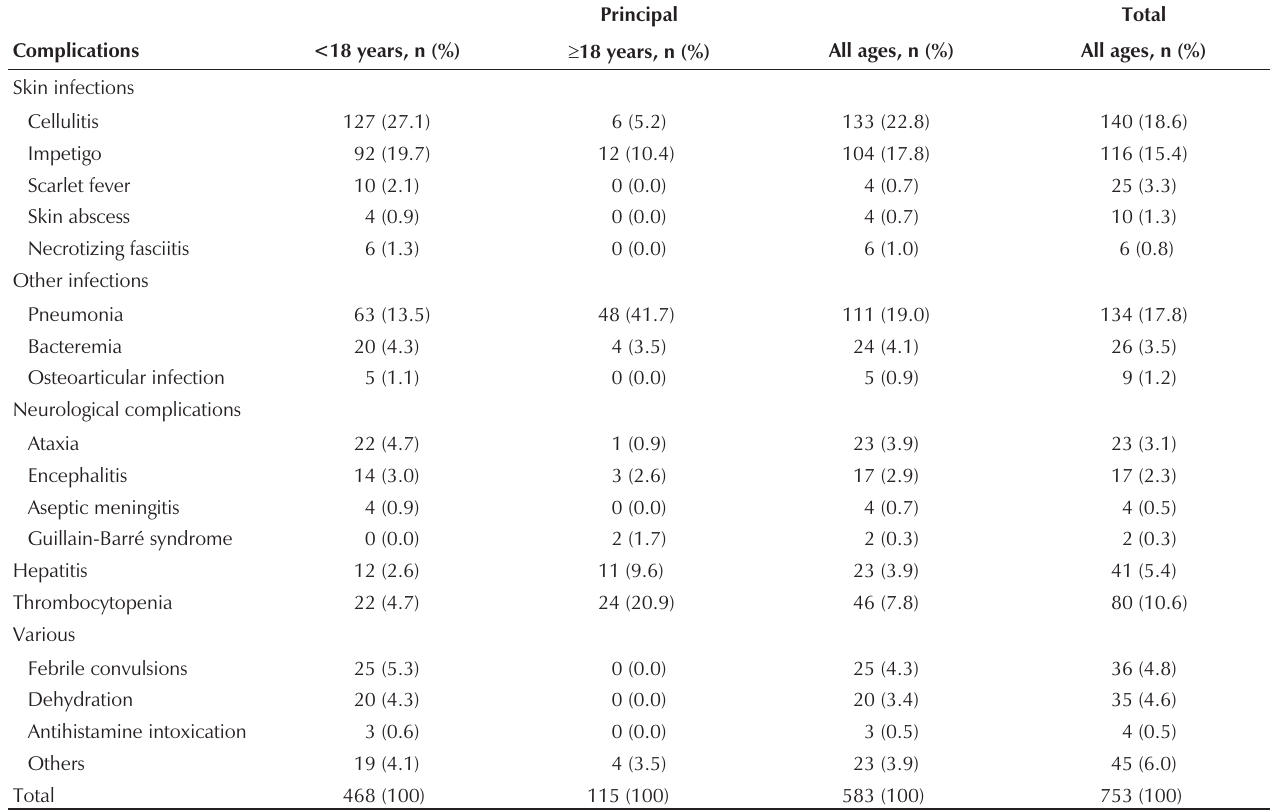
Distribution of principal complications from varicella infection by age category, Quebec, April 1994 to March 1996